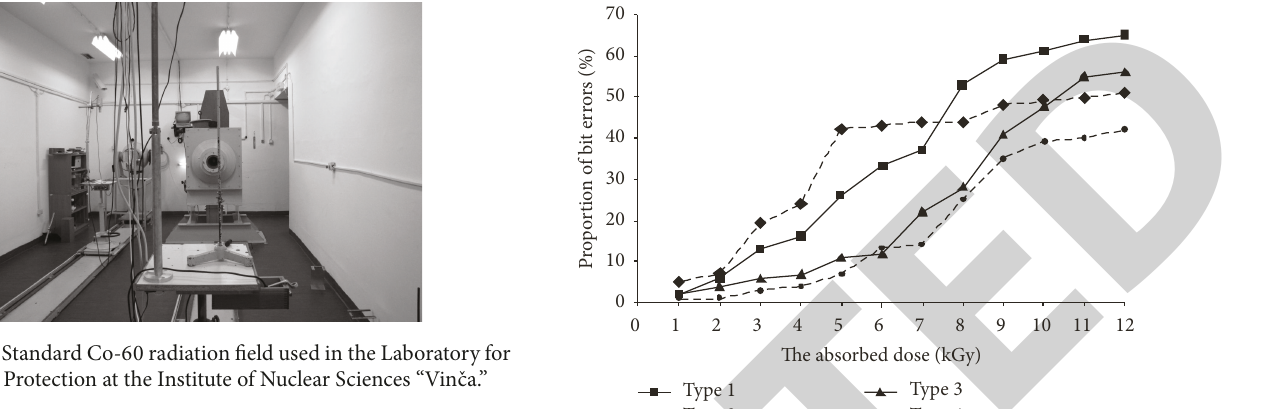
the cells (alternately writing 1 and 0) before radiation, while chip connections remain nonpolarized during the radiation.